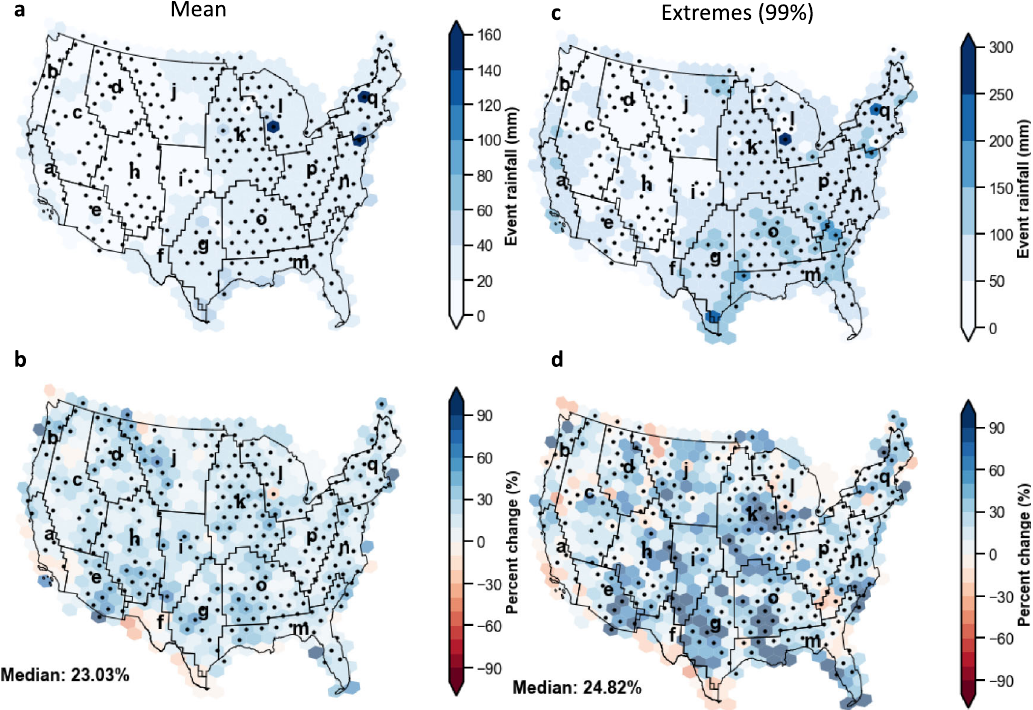
Fig. 2 Future increase in two-year fl ood-producing mean and 99 th percentile event rainfall (mm) at 2.5-deg spatial resolution, grouped by Bukovsky climate divisions. a Retrospective mean event rainfall, b Percent changes (pseudo global warming minus retrospective simulation), c Retrospective extreme event rainfall (99th percentile), and d Percent changes (pseudo global warming minus retrospective simulation) in extreme event rainfall. The dots highlight signi fi cant changes with Kolmogorov – Smirnov two-side test for p -values < 0.05. Maps are produced using the Python package Matplotlib and